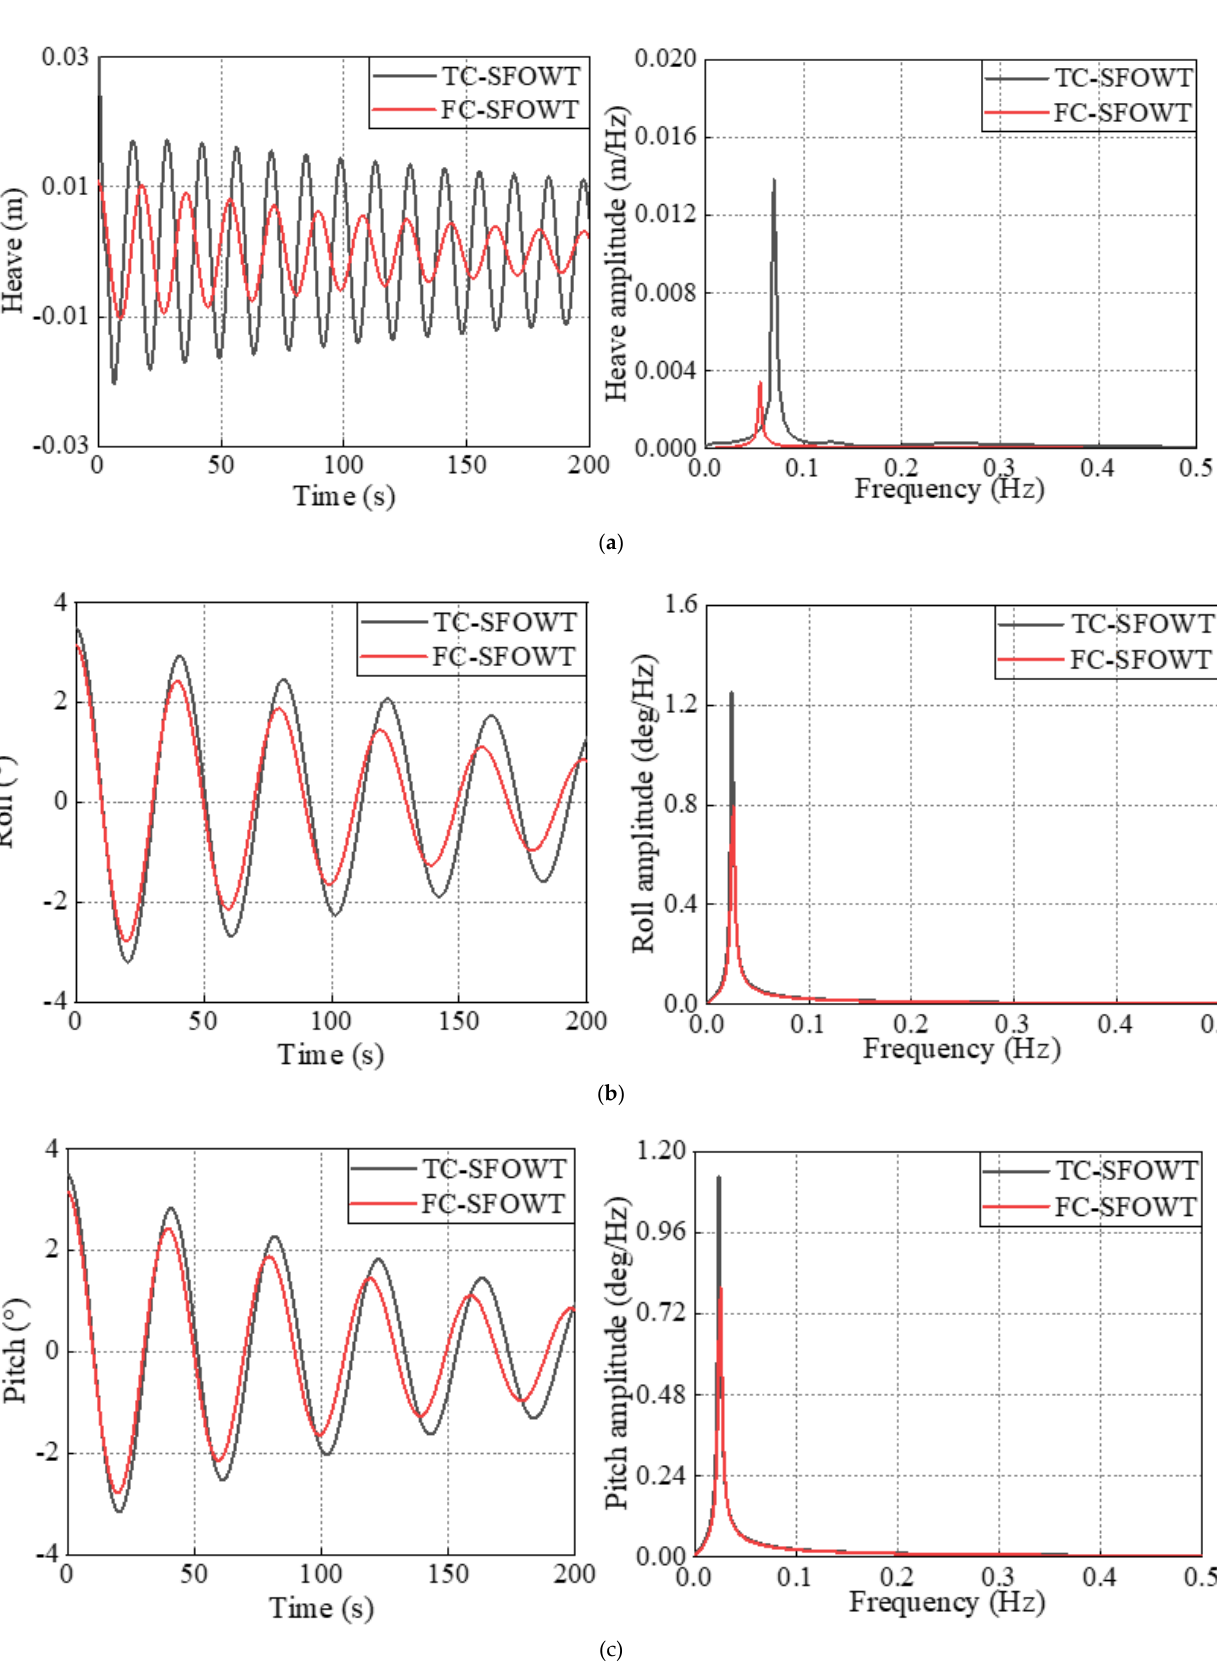
Figure 11. Free-decay and frequency spectrum. ( a ) Free-decay in heave motion, ( b ) free-decay in roll motion, ( c ) free-decay in pitch motion.